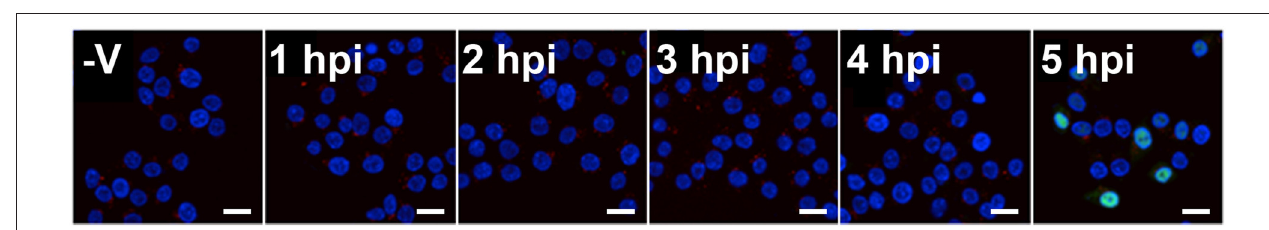
Frontiers in Microbiology |